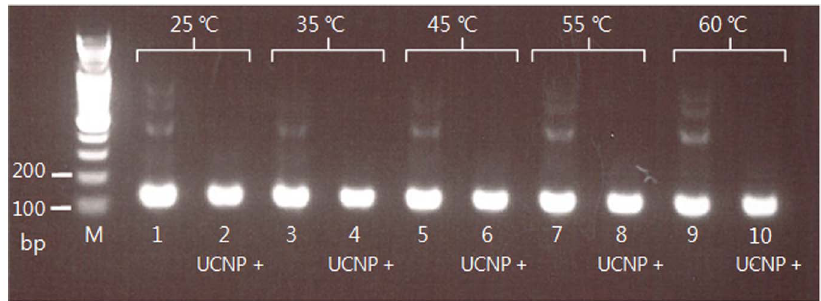
Figure 3. Effects of different annealing temperatures on PCR amplification specificity. A 120 bp 5S rDNA fragment from soybean genomic DNA was PCR-amplified with and without the use of a 40-nm-sized UCNP (1 m g/ m L). Lane M: DNA marker; lanes 1, 2:25 u C; lanes 3, 4:35 u C; lanes 5, 6:45 u C; lanes 7, 8:55 u C; lanes 9, 10:60 u C. Lanes 1, 3, 5, 7, and 9 show the results of PCRs performed in the absence of UCNPs; lanes 2, 4, 6, 8, and 10 show the results of PCRs performed in the presence of UCNPs (1 m g/ m L).